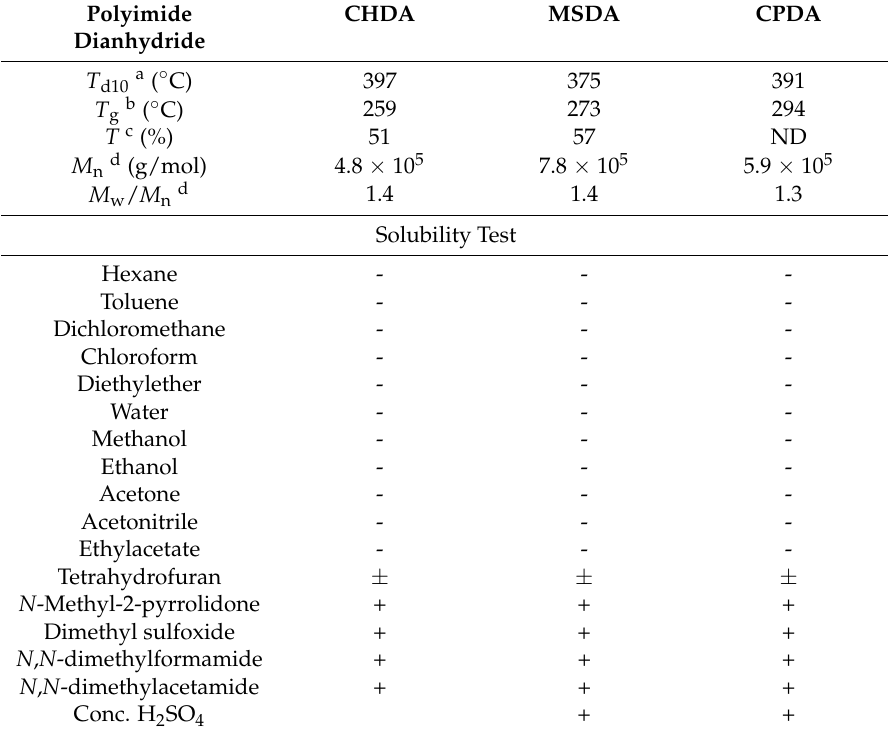
Table 1. Biopolyimide optical, thermal, and solubility